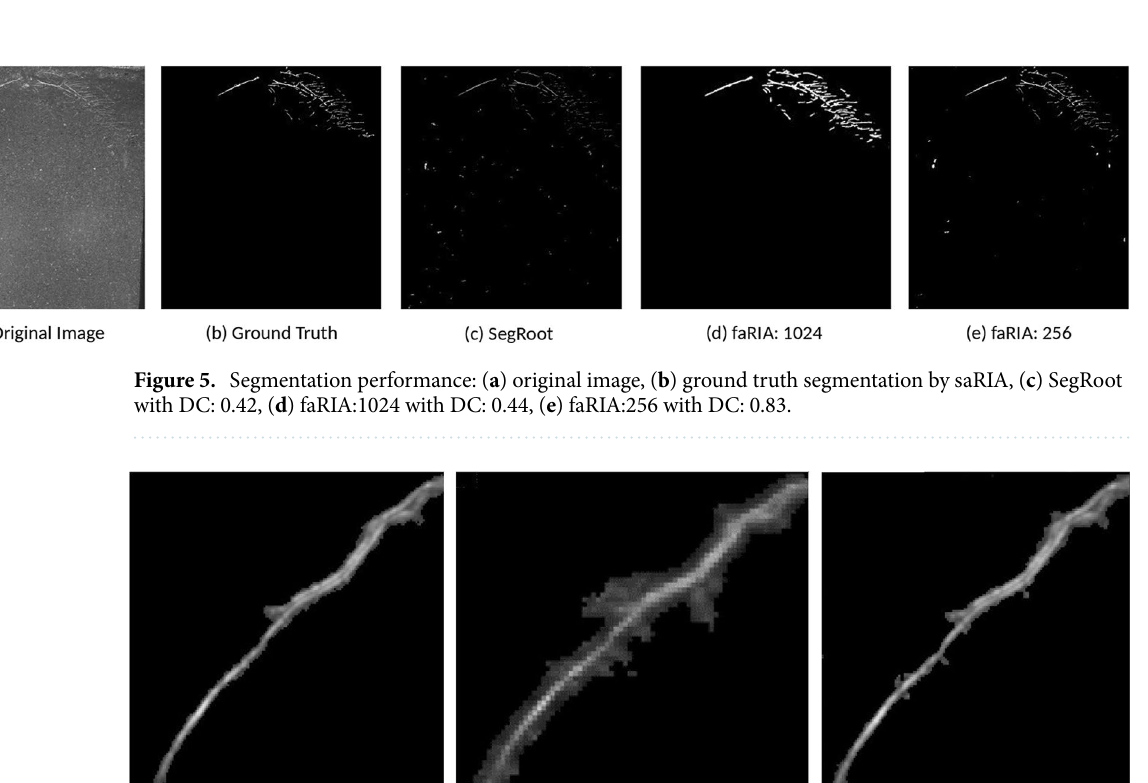
Table 5. Training performance of SegRoot, faRIA:1024 and faRIA:256 over 200 epochs.